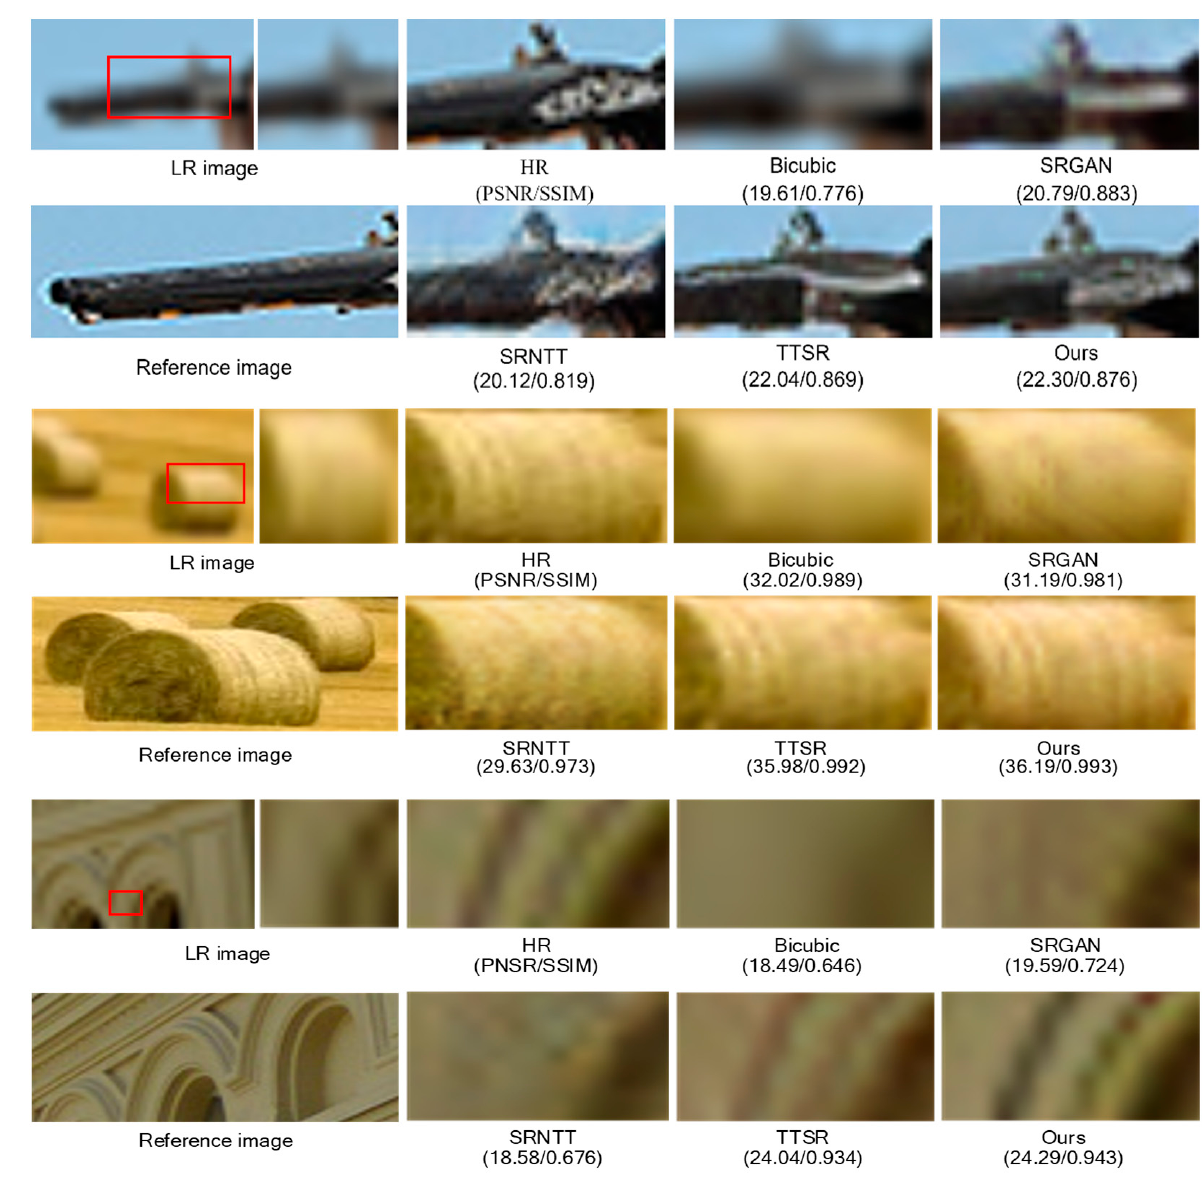
Figure 7. Visual comparison among different SR methods on the CUFED5 [19] testing set (top example), Sun80 [48], (the second example) and Urban100 [47] (the third example). To see the details of the image clearly, the area marked by the red frame is enlarged.